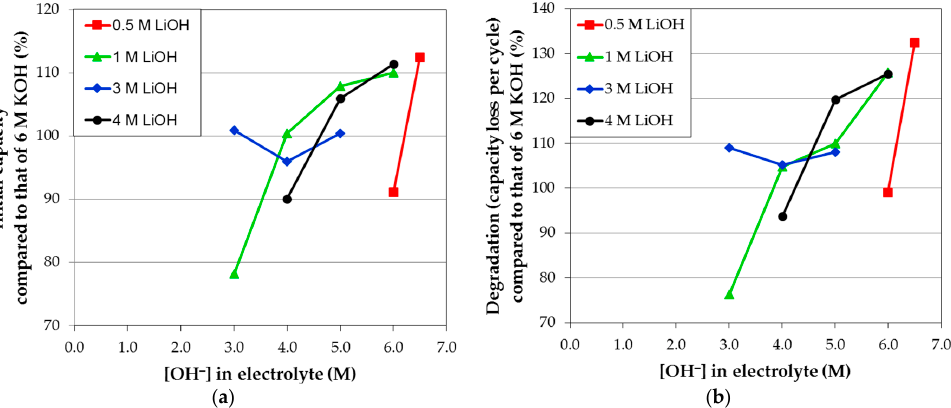
Figure 12. Plots of ( a ) the initial capacities and ( b ) degradation performances normalized to those of 6 M KOH aqueous solution vs. the total OH − concentration in solution for various electrolyte mixtures of KOH and LiOH. The trends in activation power (indicated by the initial capacity) and degradation are similar: higher total OH − concentration in solution corresponds to higher activation power and degradation. However, an exception is observed with the KOH-free solution with lower OH − concentration (the leftmost data point of the 3 M LiOH series), which unexpectedly shows a higher activation power and a higher degradation compared to the mixed solutions in the same series. Such abnormality was found in many similar cases in this study (see data in Table B1).